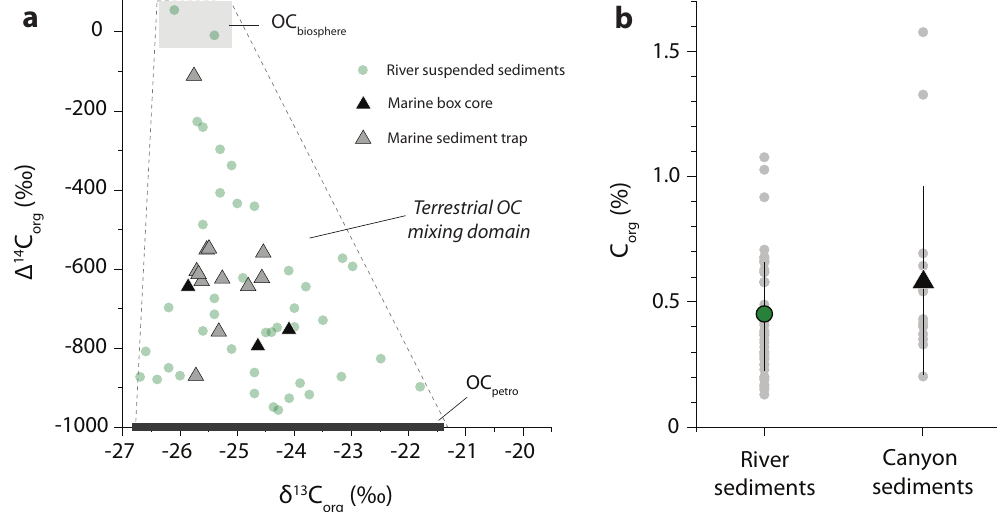
Figure 3. Composition of marine sediments in the Gaoping Canyon (Fig. 1) fed by periodic hyperpycnal flows. (a) Stable and radioactive isotope compositions of organic carbon ( δ 13 C org and ∆ 14 C org , ‰) in marine sediments (sediment trap and box core) from the Gaoping Canyon, along with river suspended sediments of Taiwan (as shown in Fig. 2b). (b) Organic carbon concentration (C org , %), with mean ± standard deviation shown by large symbol and whiskers for river suspended sediments and canyon sediments (trap and core) from the Gaoping